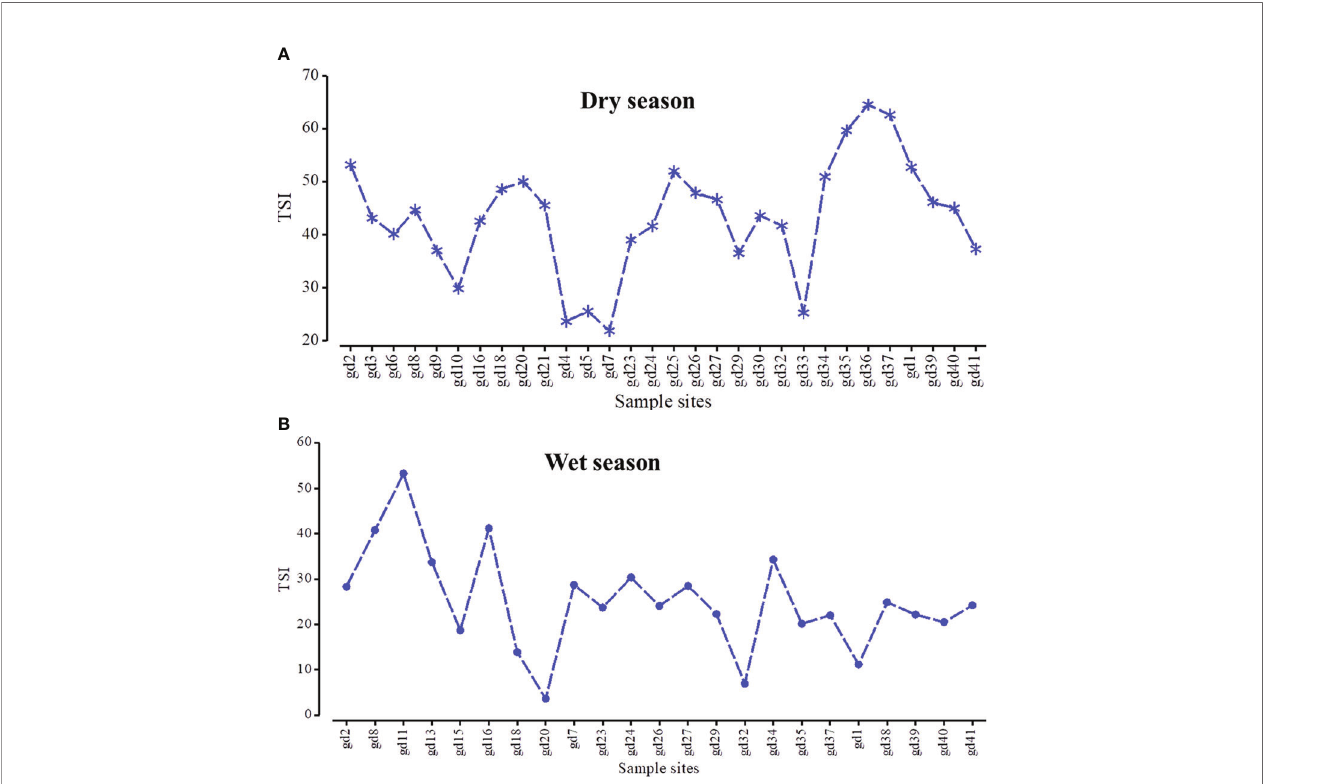
FIGURE 4 | The spatial distribution of trophic state index in dry (A) and wet (B) seasons across the mangrove forest.